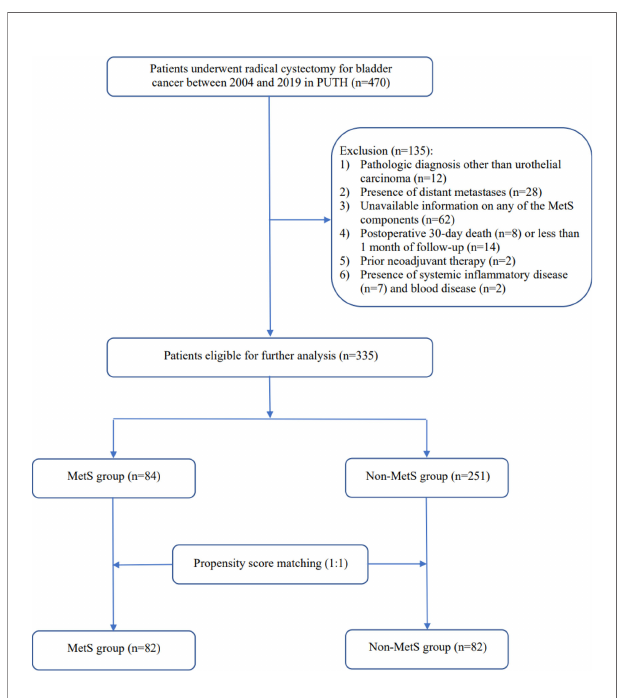
FIGURE 1 | Flow chart of patient